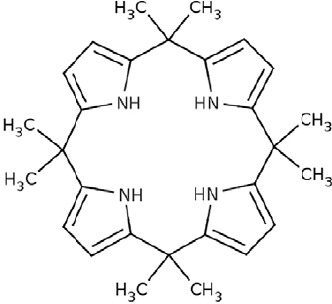
Figure 1. Structure of meso -octamethylcalix[4]pyrrole (KP). The 1 H NMR, 13 C NMR and FT-IR spectra are provided in Supplementary For pyrrole units, one strong and sharp peak at 3443 cm − 1 responds to N-H stretching while a less intensive peak at 3105 cm − 1 corresponds with =C-H stretching from an aro- matic ring. The successive peaks at 2970, 2934 and 2870 cm − 1 reflect C-H stretching bonds from methyl groups. Stretching bonds from pyrrole units and methyl groups indicate presence of meso -octamethylcalix[4]pyrrole.